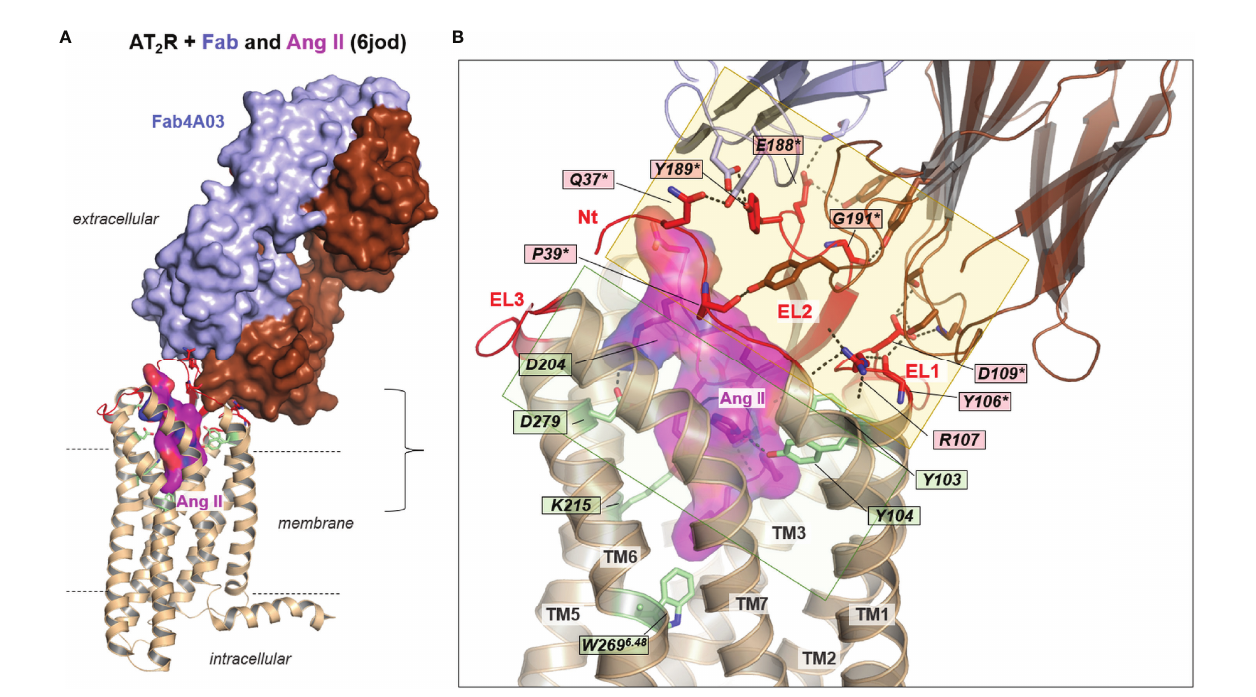
FIGURE 6 | AT 2 R in complex with an antibody Fab-fragment and Ang II [PDB ID: 6jod (66)]. (A) The receptor is presented as a backbone cartoon, the ligand and the Fab are visualized with surfaces for clarity reasons. Amino acids involved in ligand and Fab binding are shown as sticks. Extracellular loops are colored red. (B) Ang II is bound deep within the helical bundle. Signi fi cant interactions can be observed with helices TM2, TM5, TM6, and EL2 (M197 backbone, R182). EL2 is involved simultaneously in Fab binding, namely with residues located in the central EL2 (E188, Y189, G191 backbone). In addition, Y106 (backbone) and D109 in the receptor EL1, contacting the Fab as well as amino acids Q37, P39 in the N-terminus. R107 in the EL1 is an important stabilizer of this constellation by several H- bonds to the transition between the N-terminus and TM1. The translucent- fi lled squares highlight distinguishable contact regions between the receptor with Fab and the receptor with the